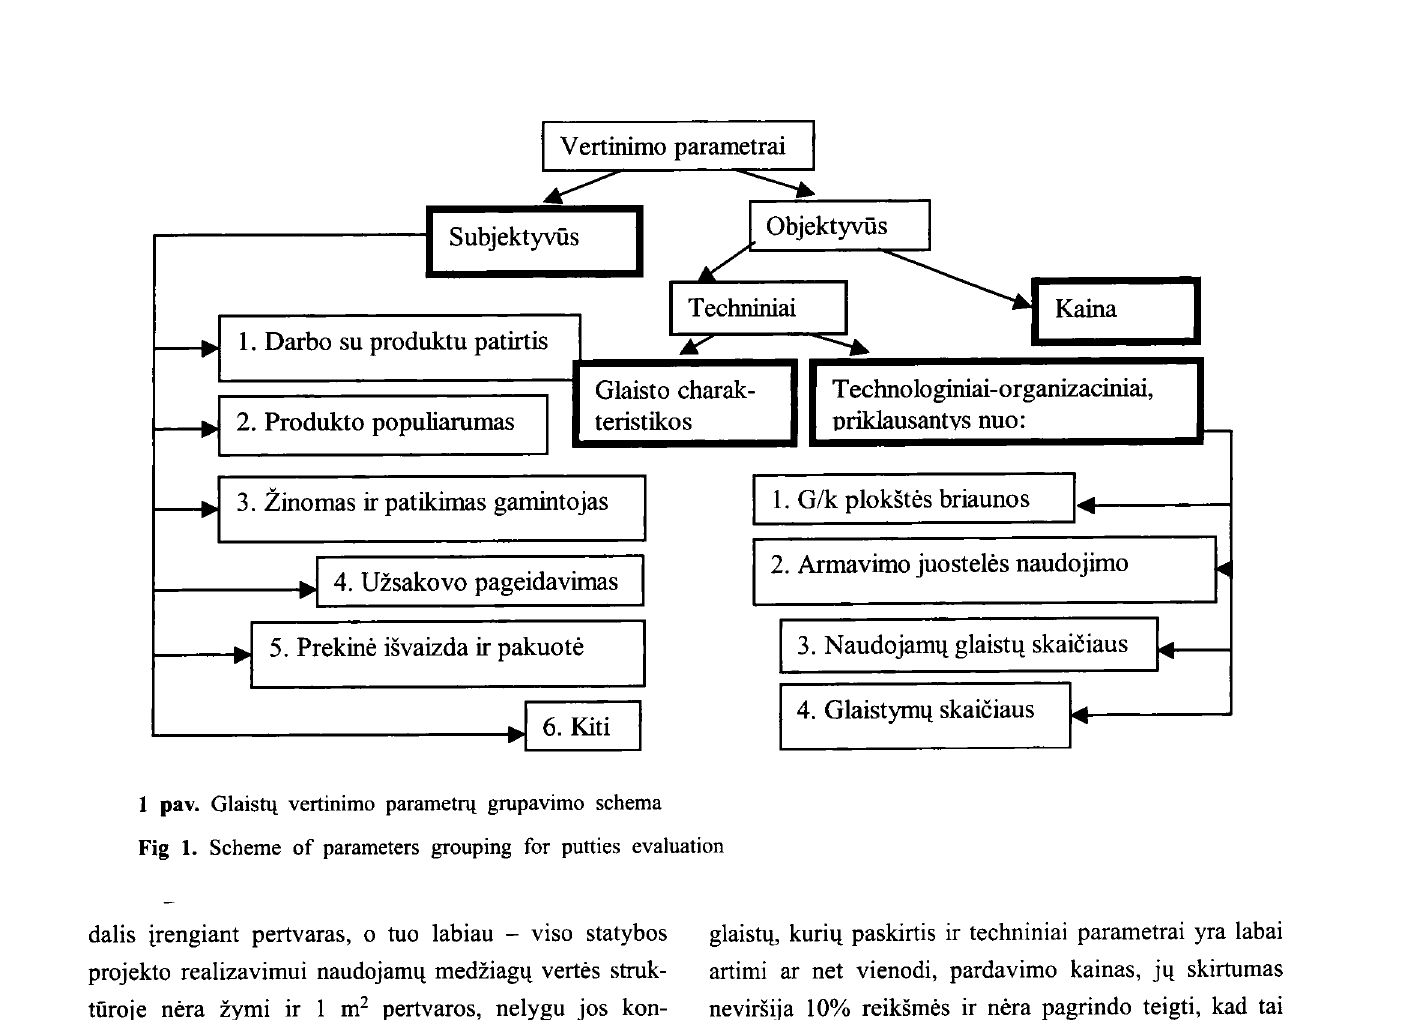
Fig 1. Scheme of parameters grouping for putties evaluation